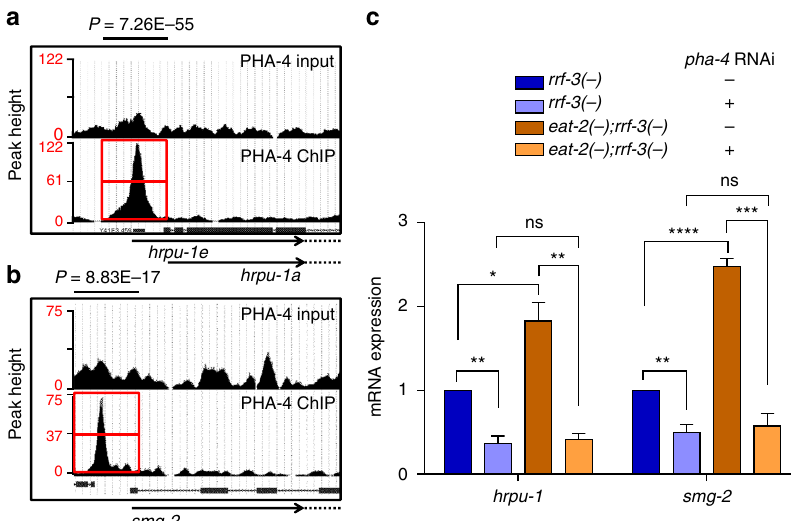
Fig. 6 The DR-speci fi c FOXA transcription factor PHA-4 regulates AS-NMD genes. a , b UCSC browser view of PHA-4/FOXA peaks on hrpu-1 and smg-2 promoters as determined by ChIP-seq analysis of unc-119(ed3)III; wgIs37 ( OP37 ) strain; data mined from MODENCODE and reanalysed using our bioinformatic pipeline. Red boxes indicate the promoter regions of hrpu-1 and smg-2 where peaks are observed. Upper panel shows peaks in input samples. Enriched peaks were identi fi ed using the peak calling algorithm MACS (v1.4.2). c QRT-PCR showing that hrpu-1 and smg-2 are upregulated in eat-2(ad465) in a pha-4- dependent manner. Expression levels were normalized to actin . Averages of three biological replicates are shown ( Error bars = SEM). Asterisks indicate statistically signi fi cant differences, as calculated by unpaired two-tailed t- test (* P ≤ 0.05; ** P ≤ 0.01, *** P ≤ 0.001, **** P ≤ 0.0001, ns non-signi fi cant). The + sign indicates the presence of pha-4 RNAi while − sign indicates control (vector)